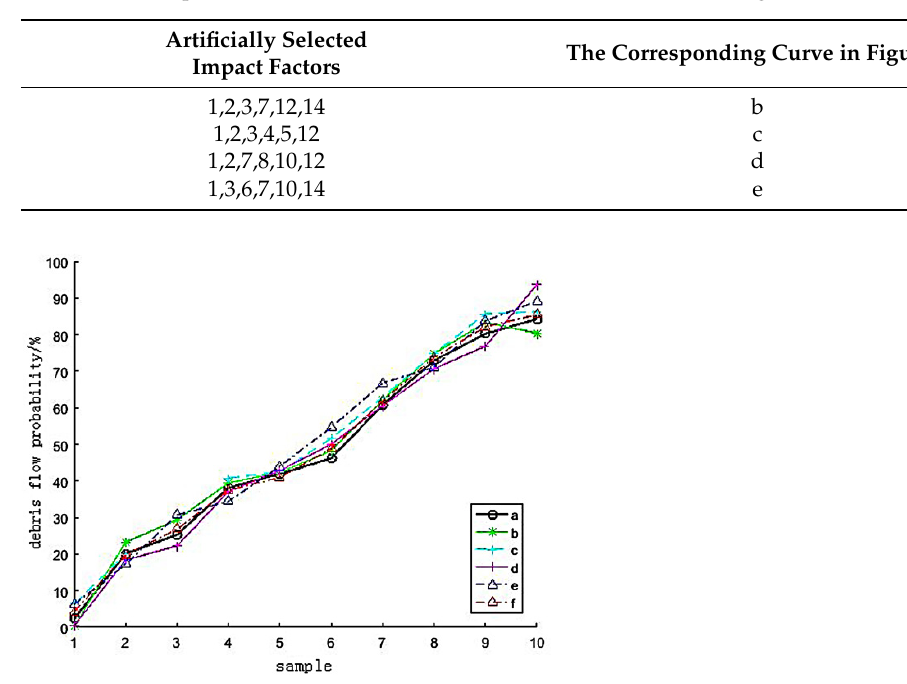
Figure 15. Comparison of prediction results of different influence